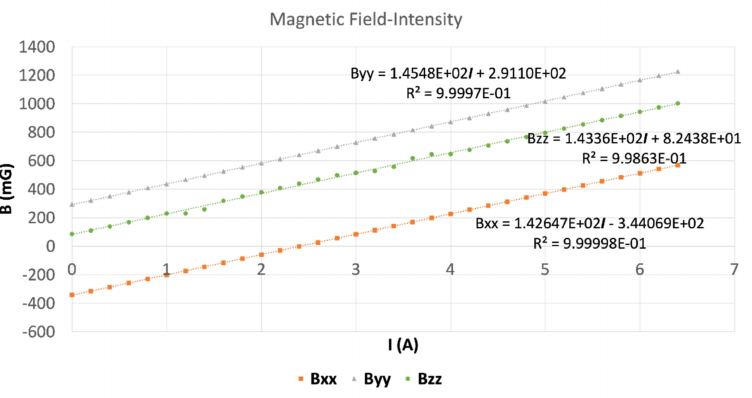
Figure 2. Relation between magnetic field in each axis and intensity applied. Linear fitting is shown for each power supply. I represents the current intensity, Bxx the magnetic field measured in the x direction, Byy in the y direction, and Bzz in the z